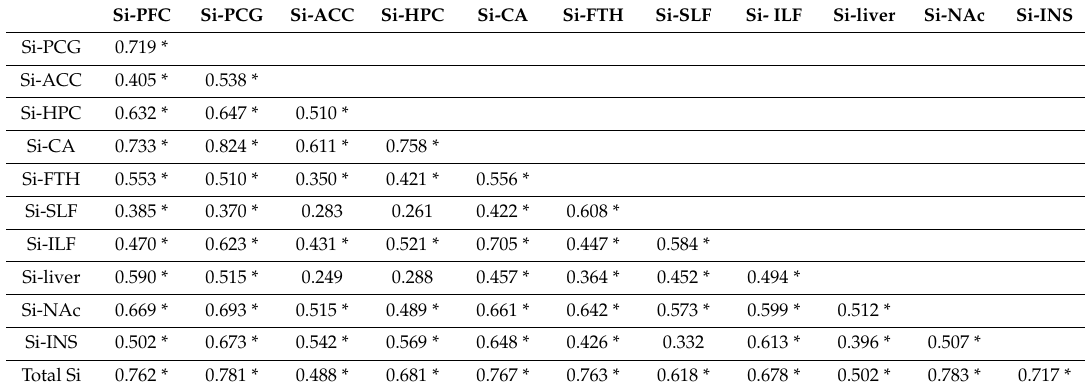
Table 6. Spearman correlation coe ffi cient for Al content in various brain structures and the liver of AUD subjects. Asterisks indicate p <